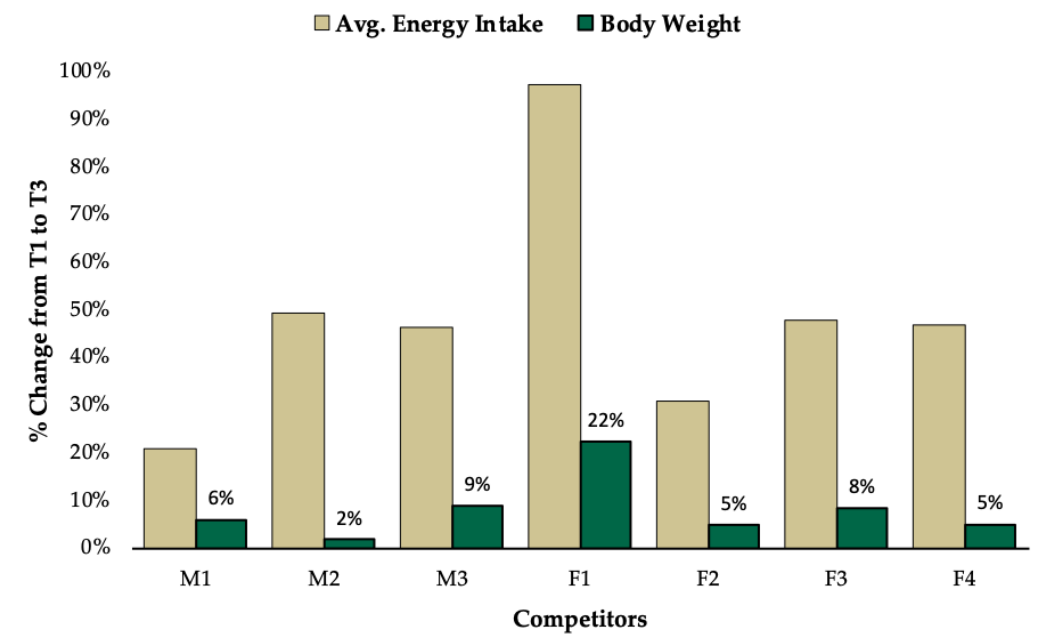
Figure 2. Percent change (% △ ) in average energy intake (kcal/day) and body weight (kg) .